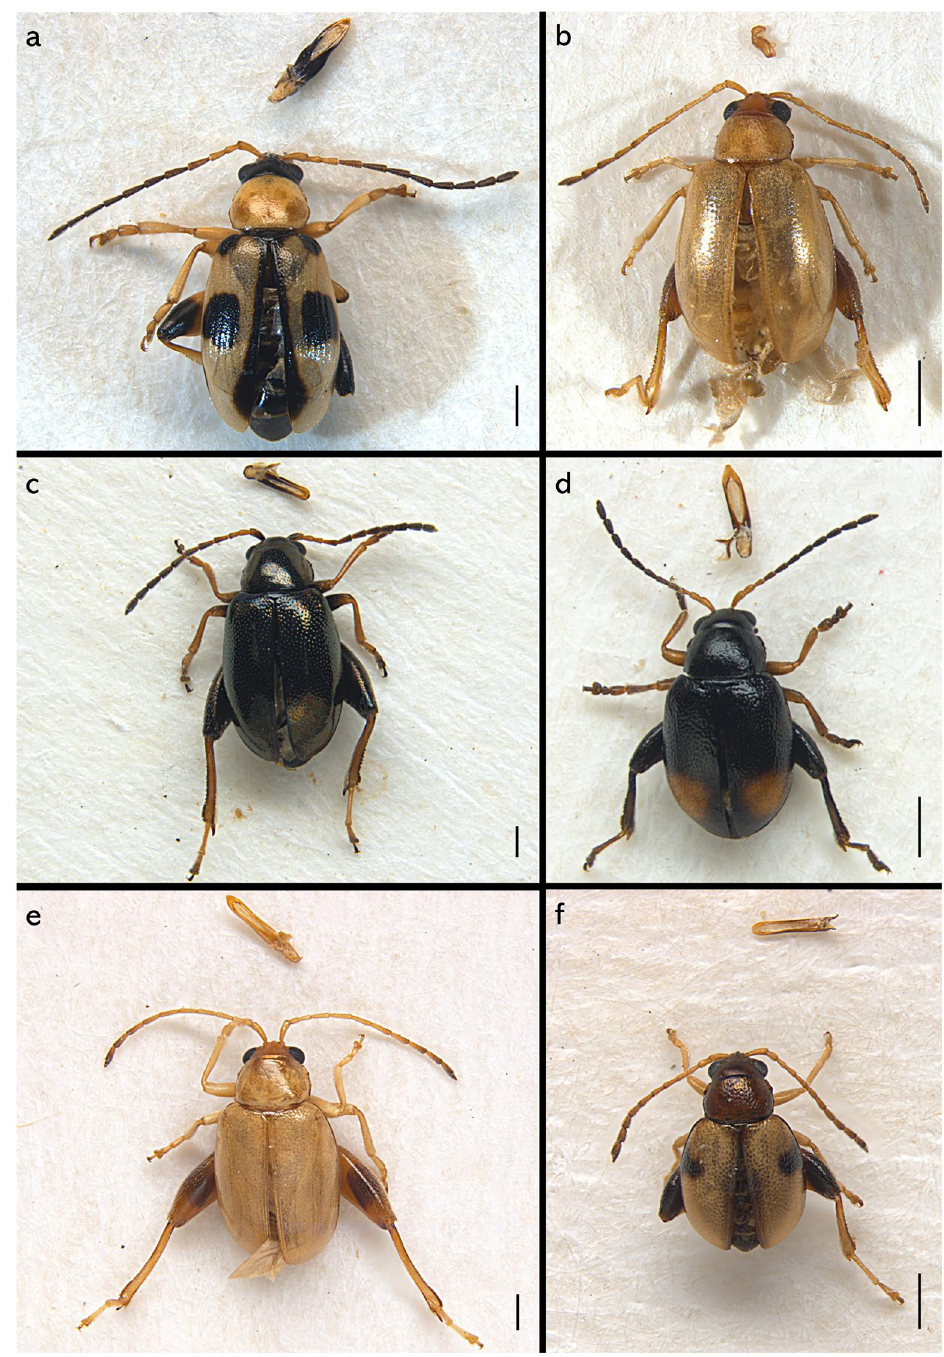
Fig 2. Photographs of voucher specimens of some of the species sequenced in this study (see S1–S3 Figs for photographs of the remaining species). Habitus and aedeagus or spermatheca of (a) Longitarsus isoplexidis ♂ ; (b) L . pellucidus ♀ ; (c) L . echii ♂ ; (d) L . holsaticus ♂ ; (e) L . foudrasi ♂ ; (f) L . lateripunctatus ♂ . Scale bar 0.5 mm.